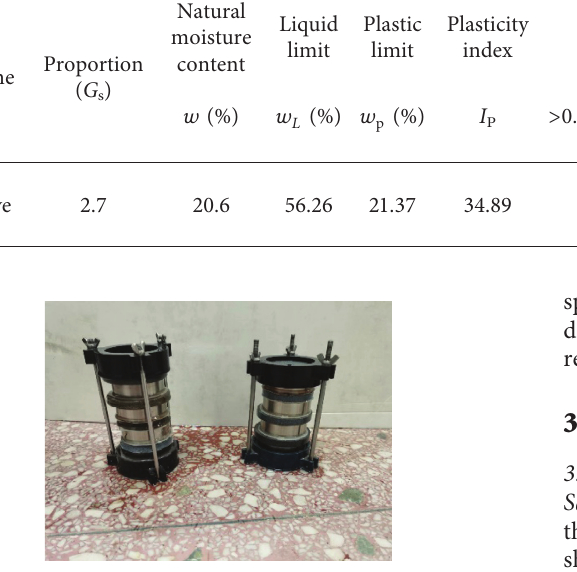
Figure 1: Overlapping saturator.